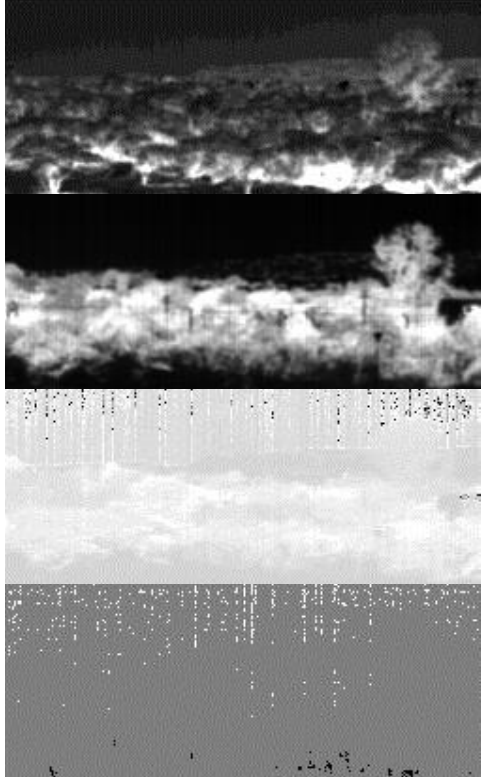
Fig.15. (a) NDVI Image (b) NIR/Red Image (c) EVI Image (d) Water Band